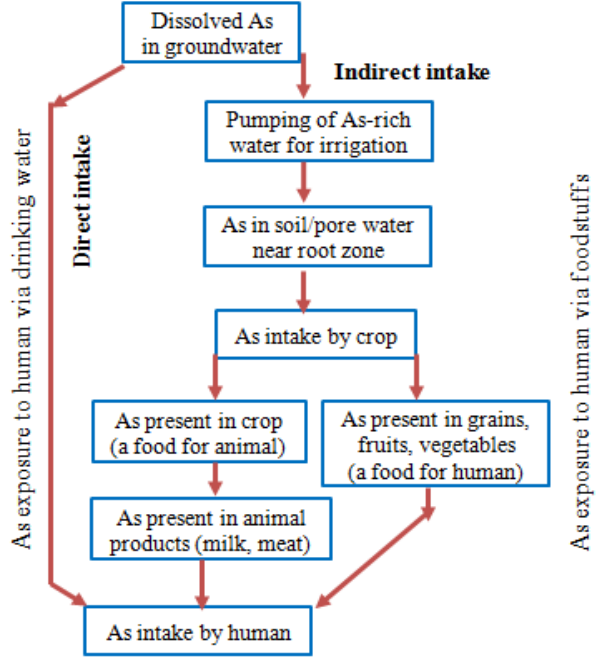
Figure 2. Flow chart of arsenic (As) intake by human (after